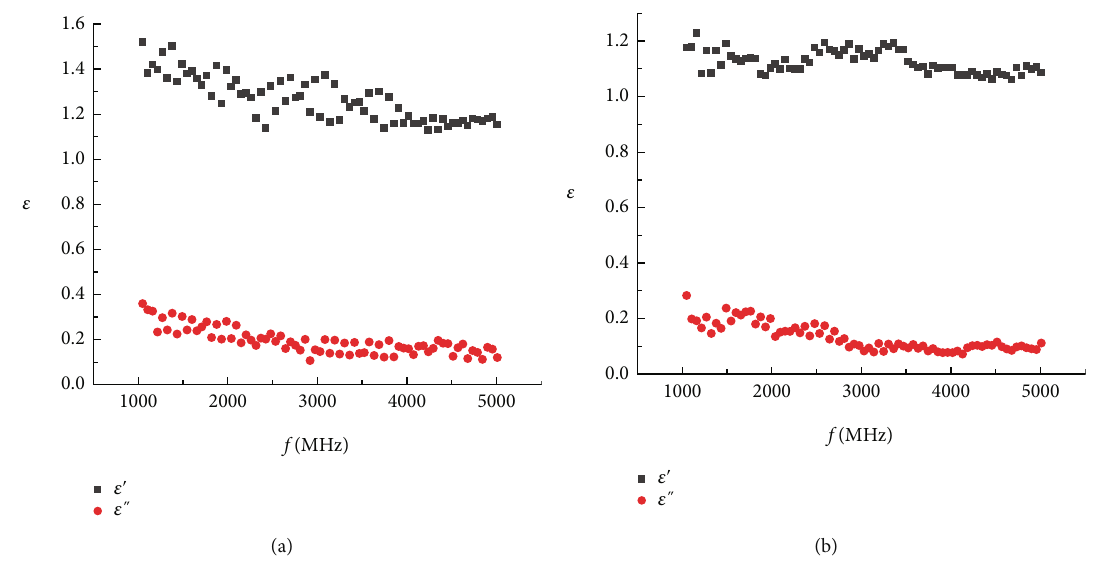
Figure 6: Measured dielectric spectra of (a) sample 1 and (b) sample